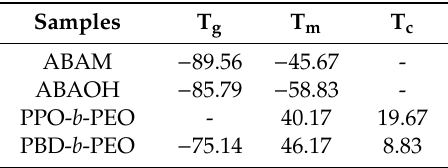
Table 2. T g , T m , and T c of the different block copolymers calculated from their differential scanning calorimeter (DSC) plots.